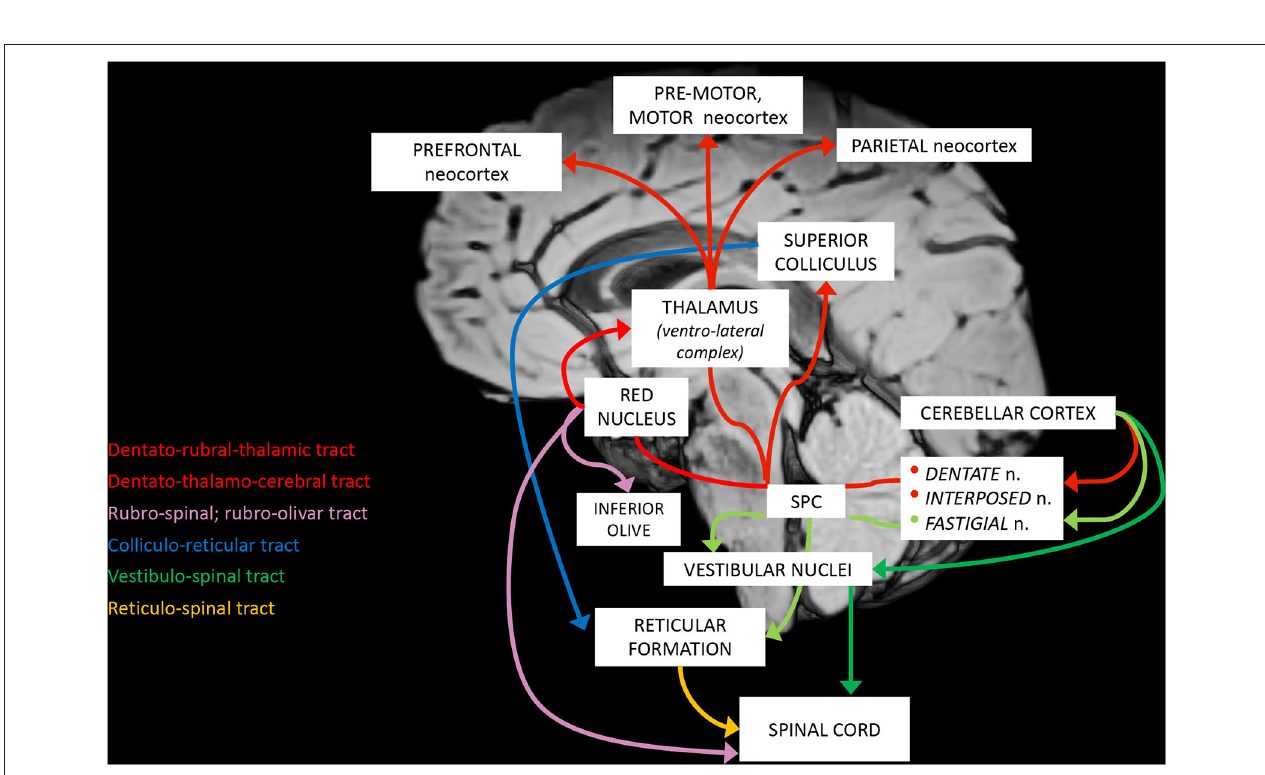
FIGURE 2 | Schematic representation of the main cerebellar efferent